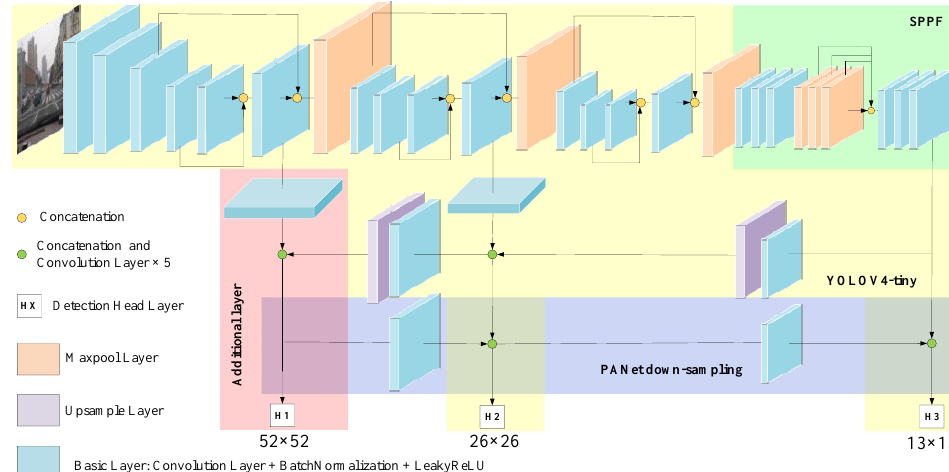
Figure 4. Schematic of the PANet module.